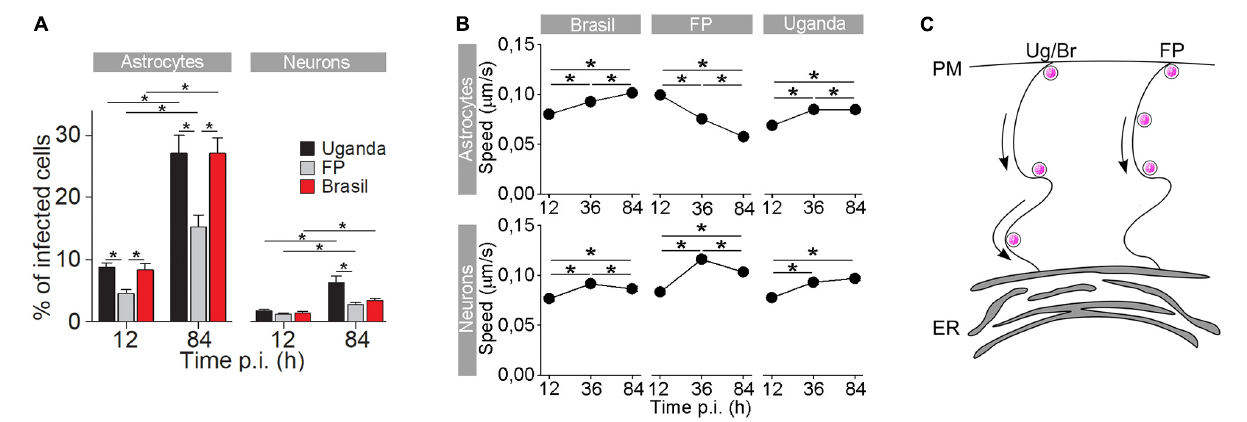
FIGURE 3 | The rate of cell infection with Zika virus (ZIKV) and the speed of ZIKV-containing endocytotic vesicles depend on the ZIKV strain. (A) The percentages of ZIKV-positive astrocytes and neurons, infected with three different ZIKV strains [Brazil 2016 (Brazil), French Polynesia 2013 (FP), and Uganda #976 1947 (Uganda)] at 12 h post-infection (p.i.) and 84 h p.i. (means ± SEM; one-way ANOVA, * p < 0.05). The percentages were determined by counting the number of immunolabeled cells versus the number of all DAPI-stained nuclei (representing single cells). Data were collected from one experiment performed in duplicate. Results are based on a total of 10 4 cells/group, counted in 16 independent fields of view (the numbers of cells counted per strain: 858–1805 astrocytes and 4882–5765 neurons). The percentages of ZIKV-positive astrocytes and neurons are different at both 12 h p.i. and 84 h p.i. in both cell types and increase with time. Note that the rate of cell infection depends on the ZIKV strain. (B) In astrocytes, the average speed of endocytotic vesicles increased with longer times p.i. for ZIKV-Br- and ZIKV-Ug-laden vesicles, while the average speed of ZIKV-FP-laden vesicles decreased. In neurons, the average vesicle speed exhibited the most prominent increase at 36 h p.i., regardless of the virus strain, and then declined the most in ZIKV-FP-laden vesicles. (C) A schematic representation of the higher speed of ZIKV-Br- and ZIKV-Ug-laden vesicles, as compared to the speed of ZIKV-FP-laden vesicles. The ZIKV is depicted as pink dots. Modified from Jorgaˇcevski et al. (2019) with